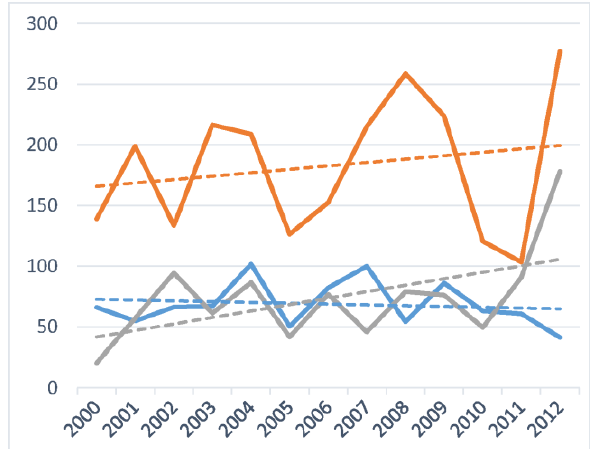
Figure 3. Graphs of the total precipitation (mm) at the Syktyvkar station, from 2000 to 2013. The precipitation is summarized by seasons (blue graph – spring, orange – summer, grey - autumn)